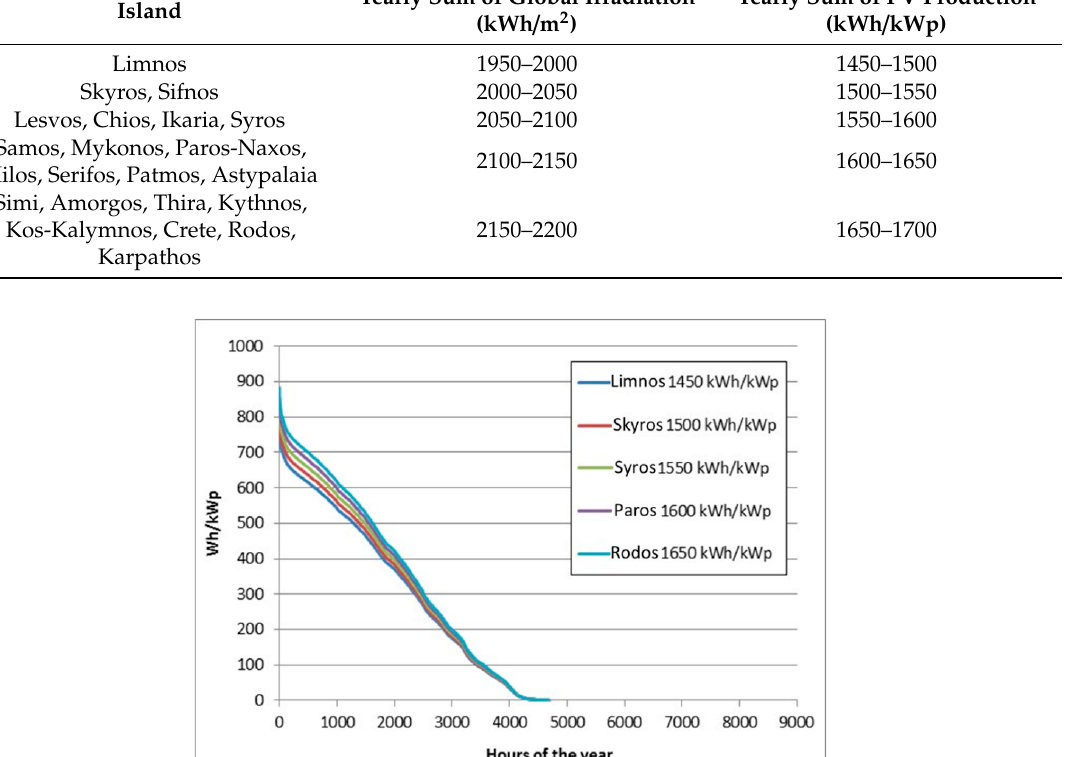
Table 7. Adjustment of yearly sum of PV production based on Photovoltaic Geographical Information System (PVGIS) [29].